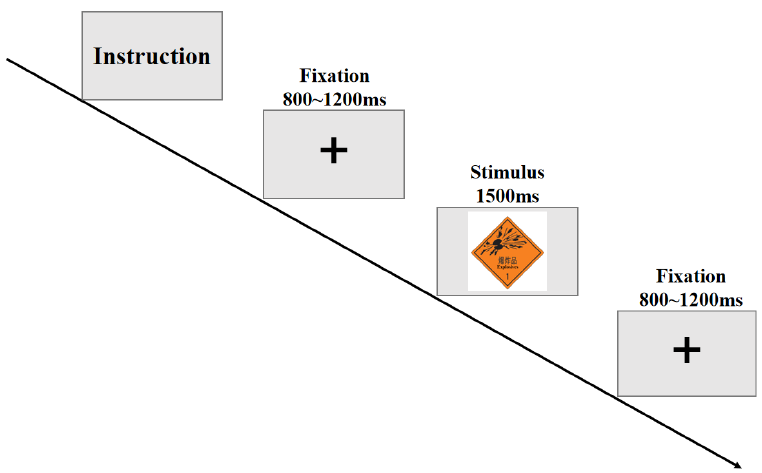
Figure 3. The ERP experimental procedure .